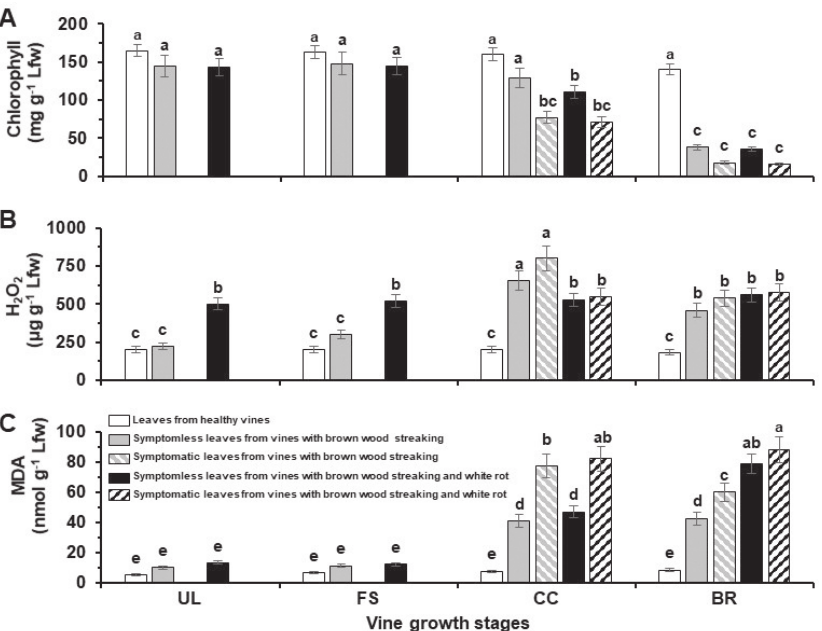
Figure 3. Total chlorophyll (A), hydrogen peroxide (H 2 O 2 ; B) and malondialdehyde (MDA; C) concentrations of ‘Italia’ leaves collected dur- ing the unfolded leaf (UL), fruit set (FS), cluster closing (CC) and bunch ripening (BR) vine growth stages, from infected or healthy vines. Data are the means of 50 replicates ± standard deviations. For each parameter, values accompanied by the same letters are not significantly different ( P ≤ 0.05) according to Fisher’s LSD